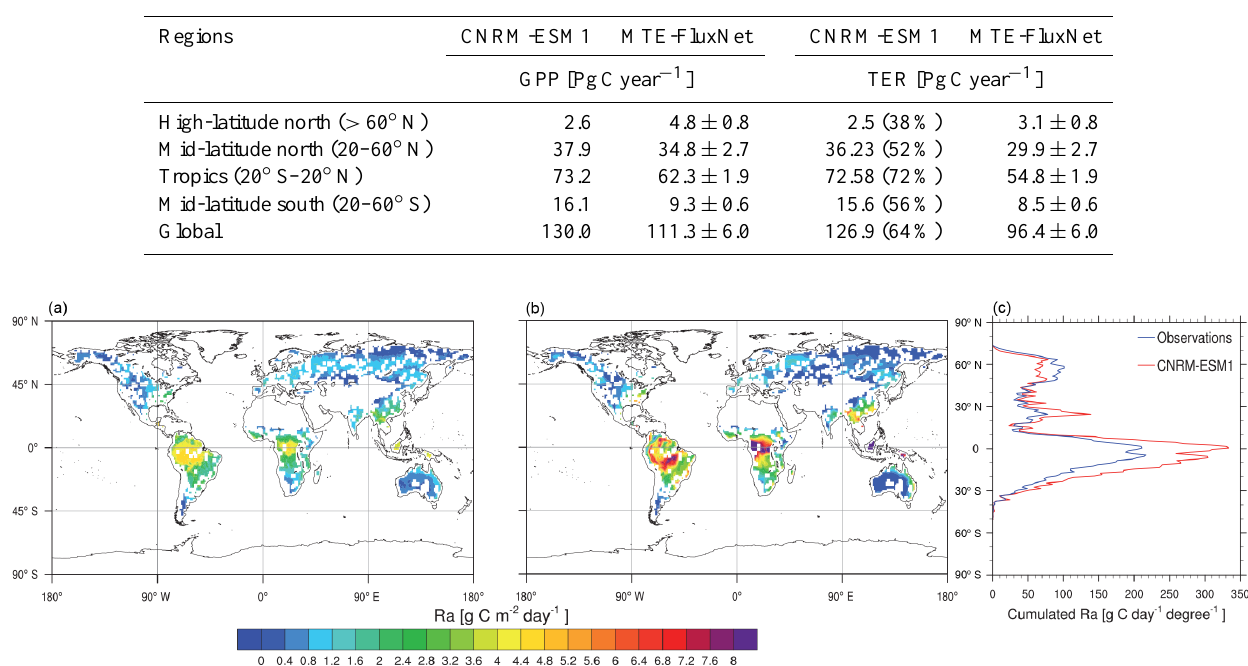
Table 2. Regional and global budget of gross primary production (GPP) and terrestrial ecosystem respiration (TER) as simulated by the CNRM-ESM1 and estimated from the FluxNet-MTE data product. Values in brackets indicate the ratio between the autotrophic respiration (Ra) and TER. The uncertainties for the FluxNet-MTE data product derive from the regional partitioning of global mean uncertainties published in Jung et al. (2011). GPP and TER fluxes are determined from a yearly average over 1986–2005.